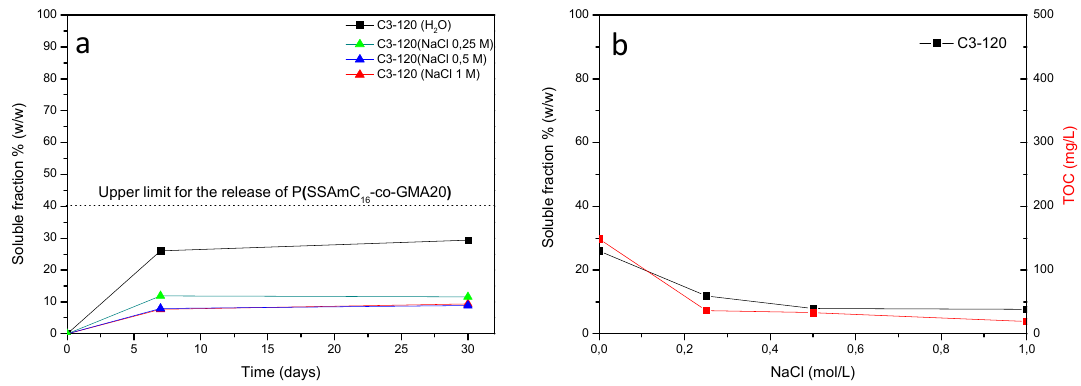
Figure 8. ( a ) Soluble fraction % ( w / w ) after immersion in ultra ‐ pure water and NaCl 0.25 M, 0.5 M, 1 M for different time periods of cured C3 ‐ 120 polymeric coatings; ( b ) Soluble fraction % ( w / w ) with the NaCl concentration after treatment for seven days when compared with the respective TOC variation.